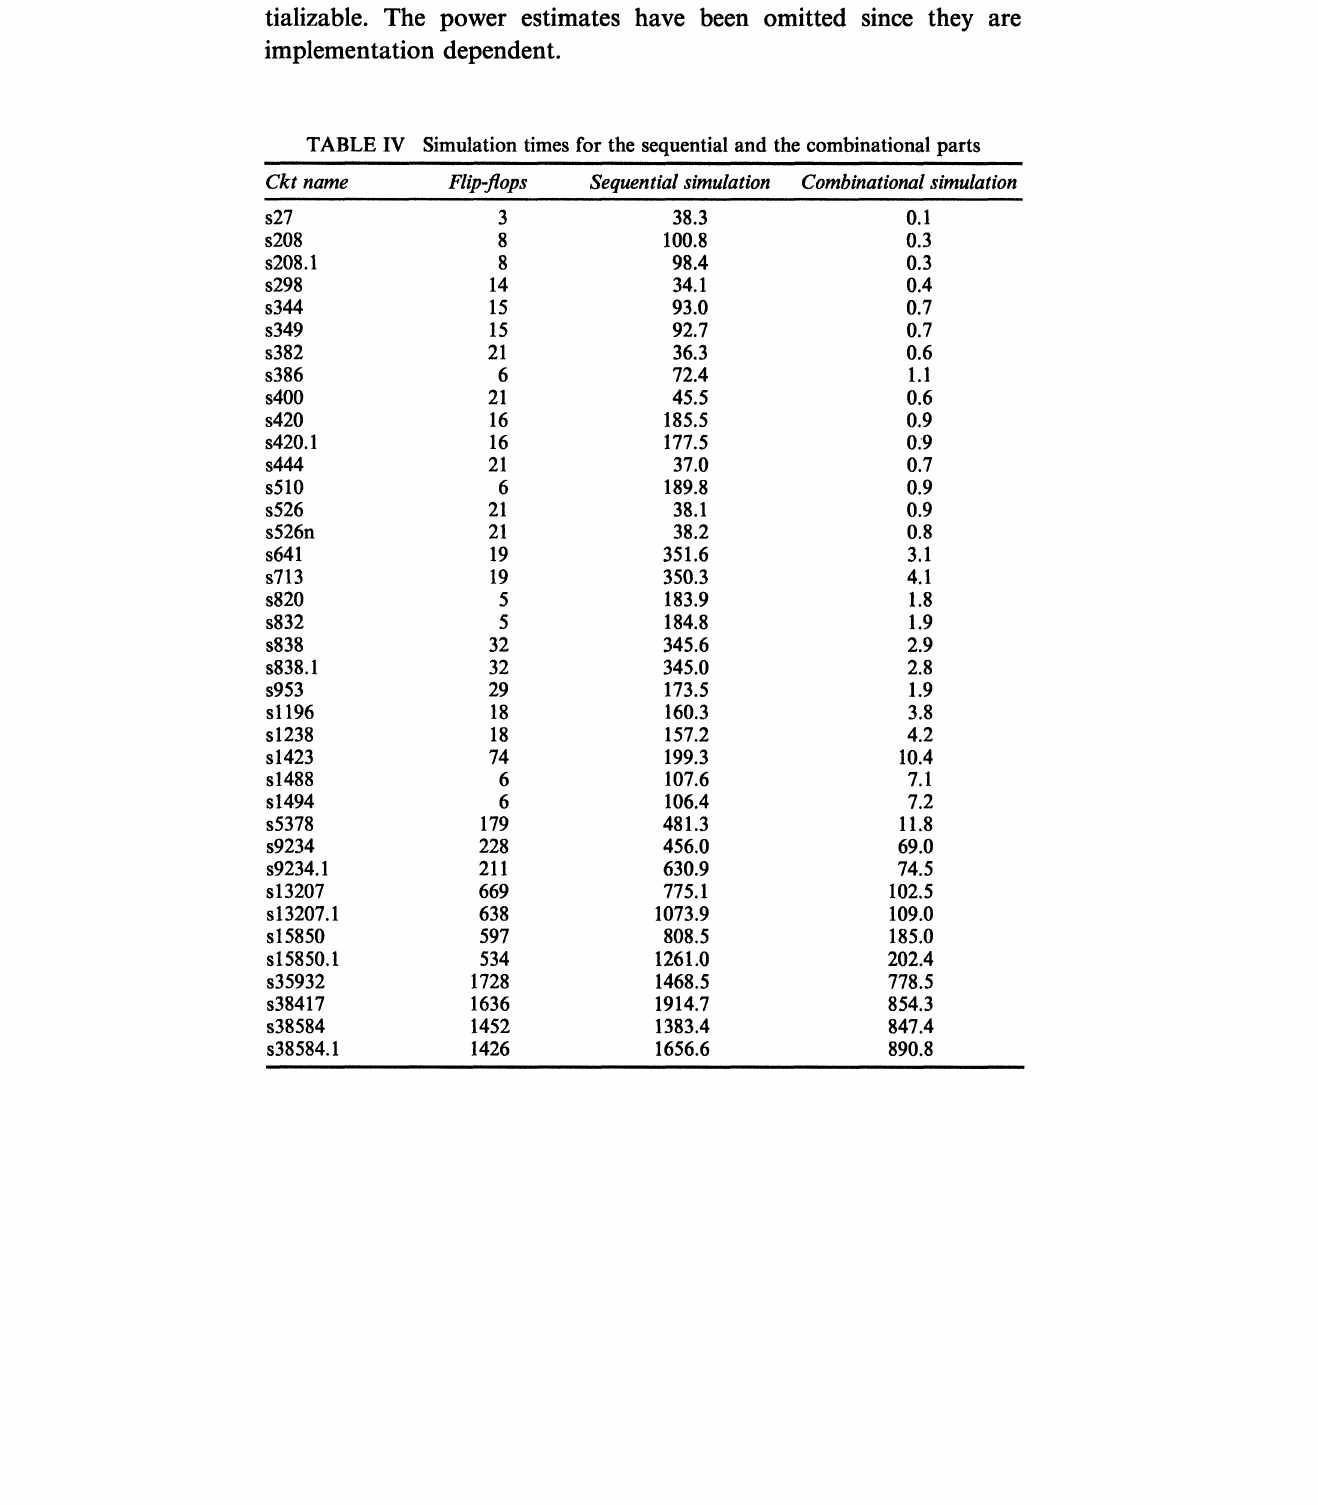
TABLE IV Simulation times for the sequential and the combinational